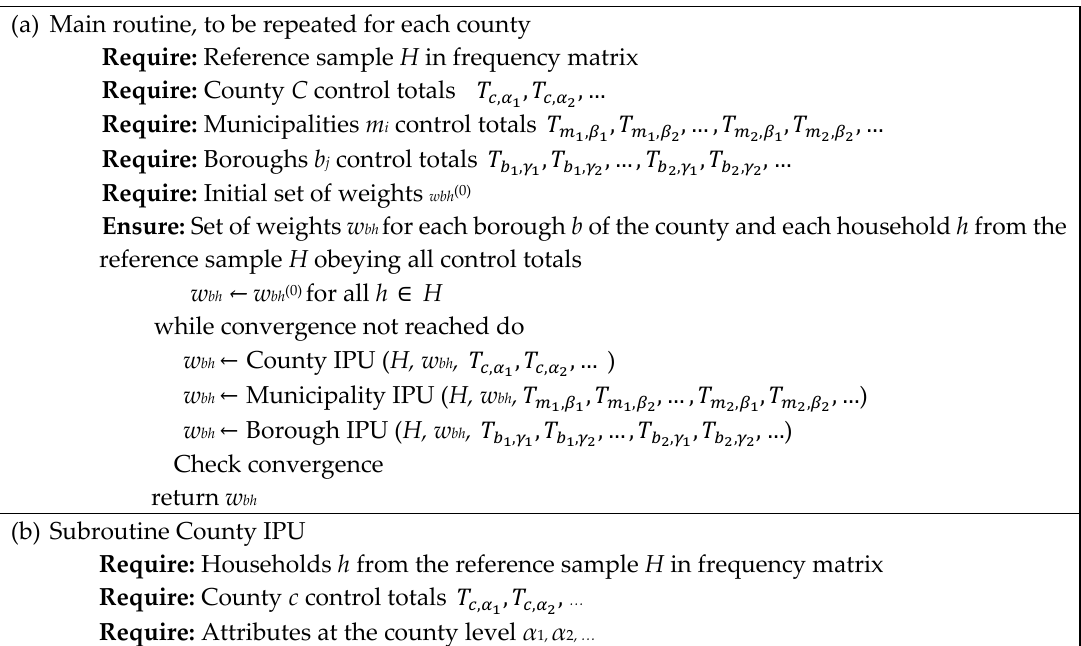
Table A3. Pseudo code of IPU with three geographical resolutions and two